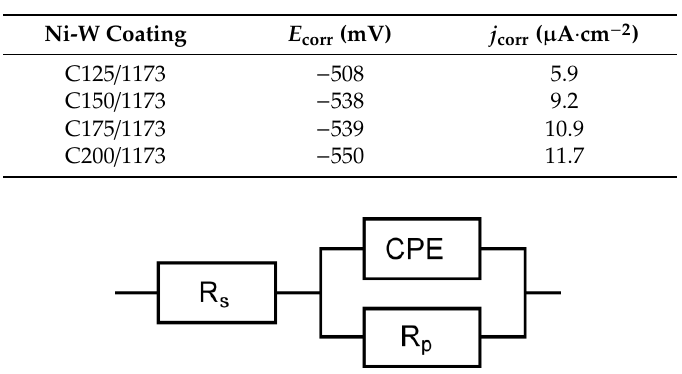
Figure 5. Equivalent circuit scheme, R s - solution resistance, CPE - constant phase element, R p - polarization resistance. Table 3. EIS parameters determined for Ni-W coatings after heat treatment in the air, in dependence on deposition current density.